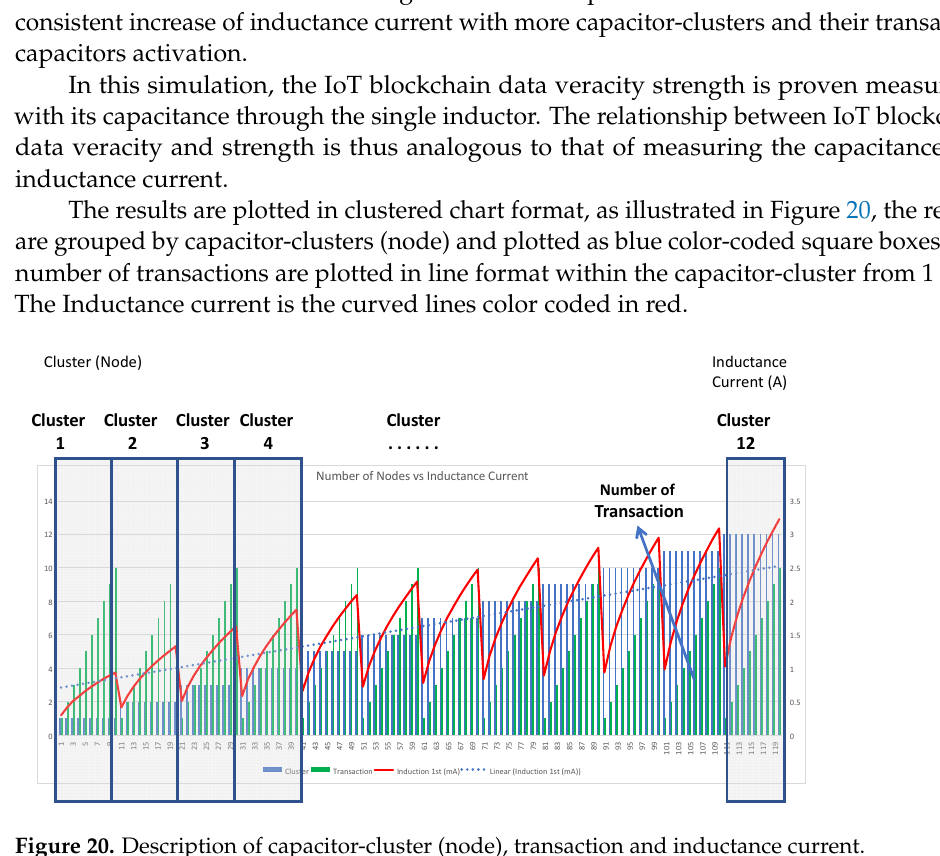
Figure 20. Description of capacitor-cluster (node), transaction and inductance current.